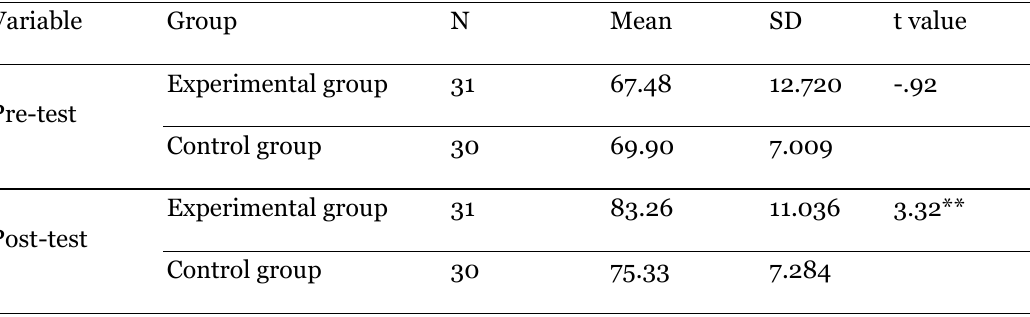
T-Test Result of the Pre-Test/Post-Test Scores Variable